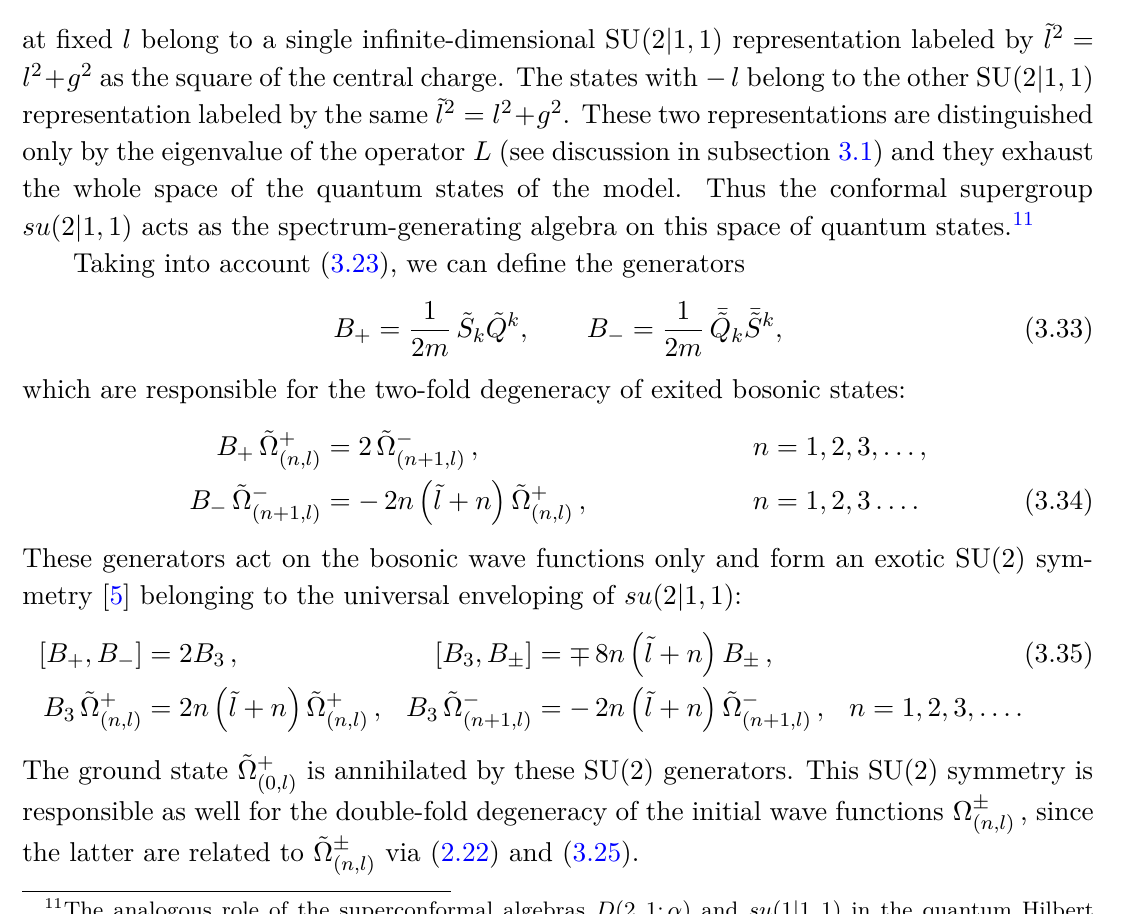
˜ Q i ¯˜ ˜ S i and S j .